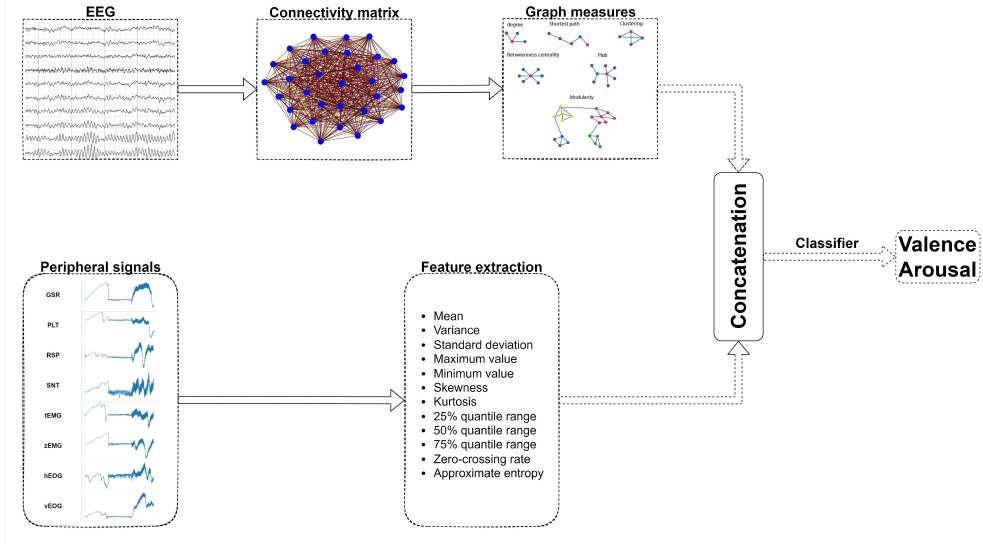
Figure 3. Analysis pipeline. The analysis includes statistical feature extraction from the peripheral physiological signals and graph measures extraction from the connectivity matrices of EEG signals. The features are concatenated before being fed to the classifier for the binary valence and arousal